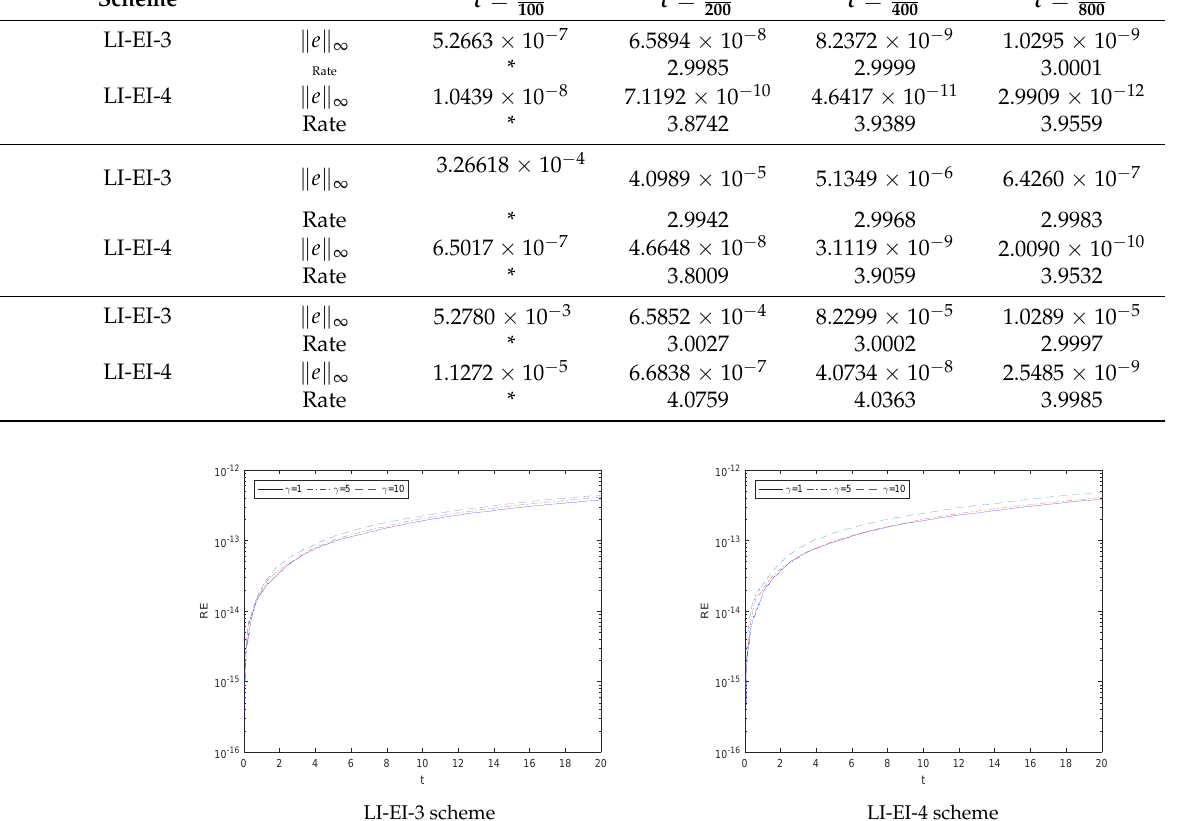
Table 3. Temporal accuracy of the proposed schemes for different γ with h = 2 π /16.